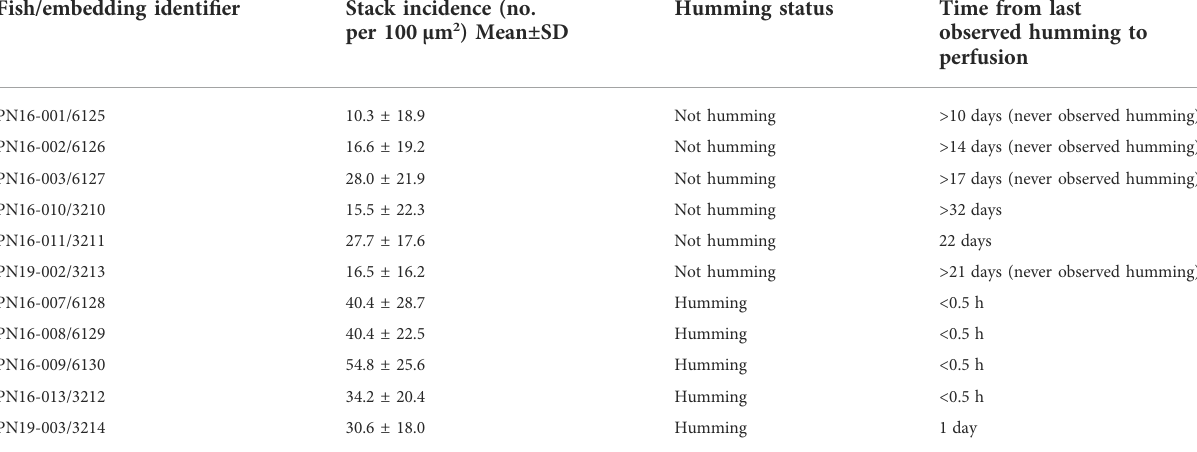
TABLE 2 SR stack incidence in sonic muscles from humming ( N = 5) vs. non-humming ( N = 6) fi sh. Fish/embedding identi fi